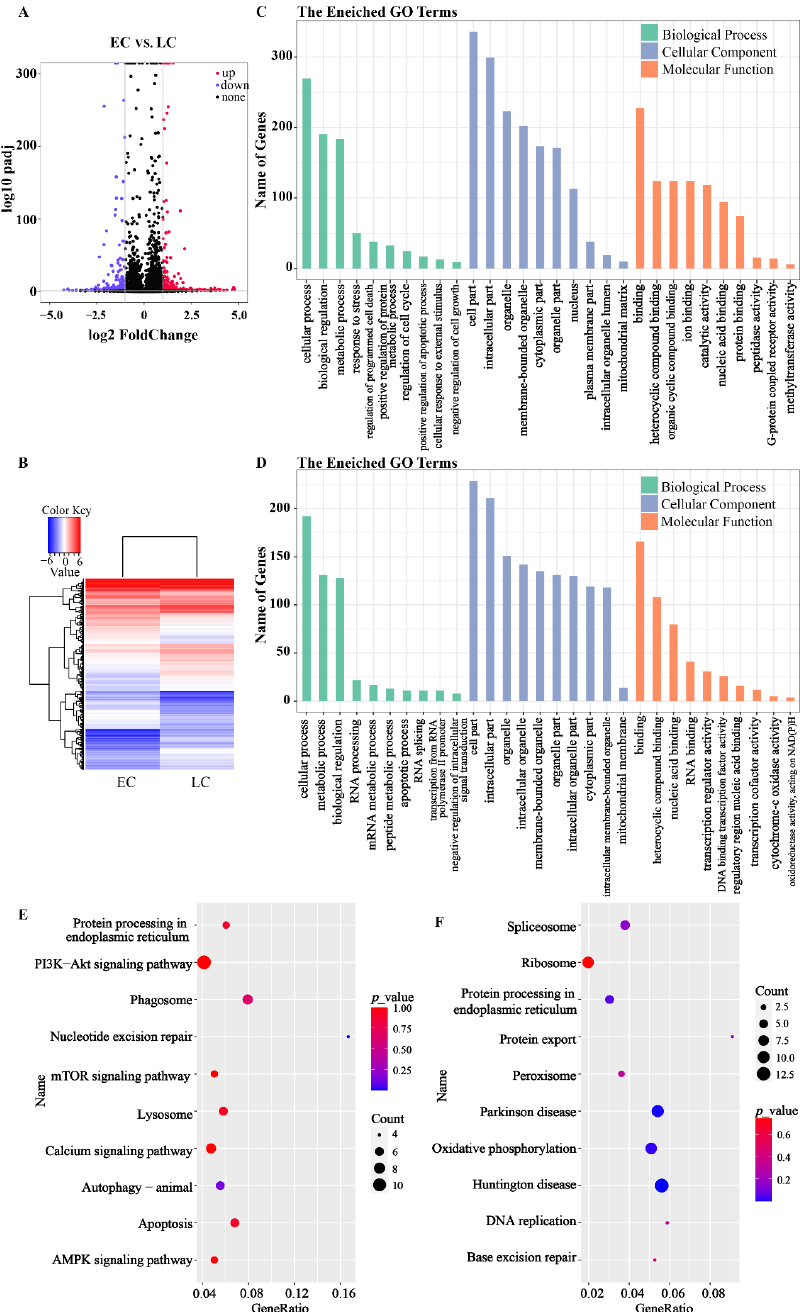
Figure 2. DEGs analysis between pig early cleavage embryos and late cleavage embryos of PA with one repeat per group. ( A ) The volcano plot shows the upregulation and downregulation of